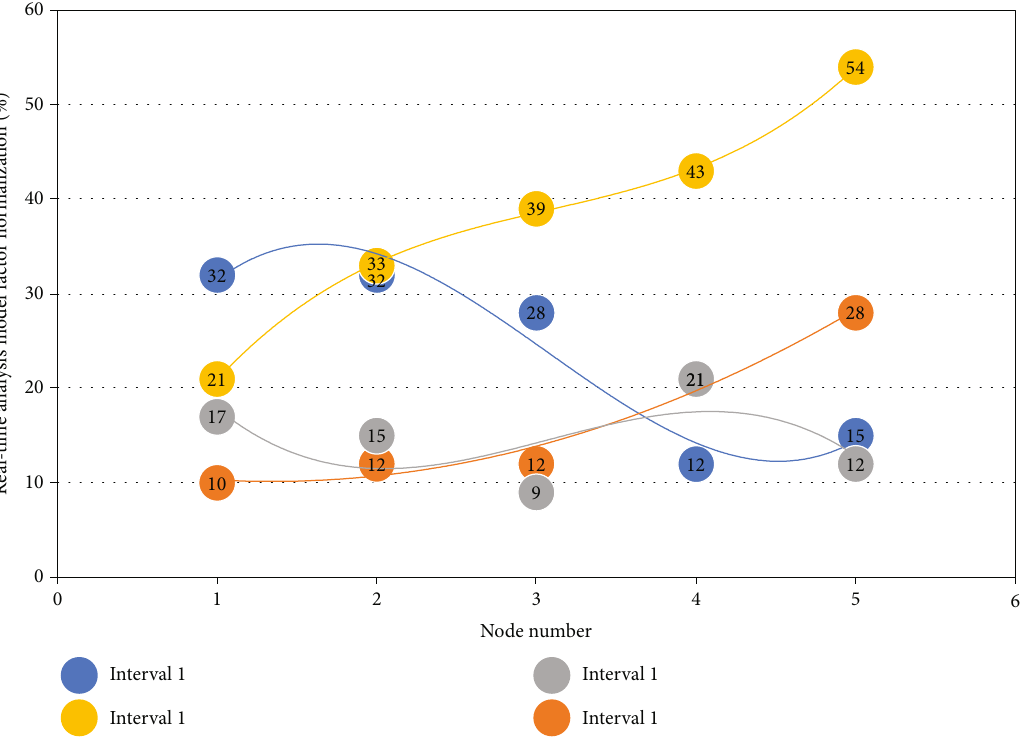
Figure 4: Normalization of real-time analysis model